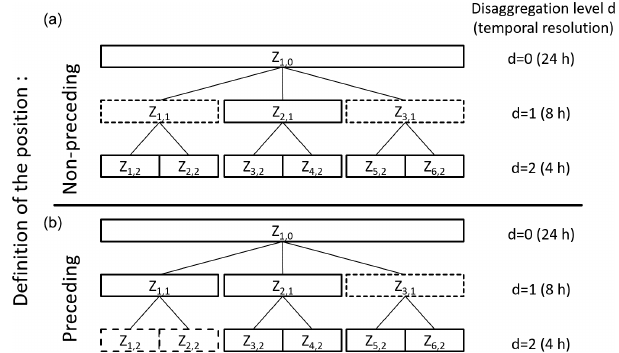
Figure 3. Scheme for position definition in non-preceding (a) and preceding (b) cascade models. The dashed boxes indicate the time steps taken into account for position definition of the time step Z 2 , 1